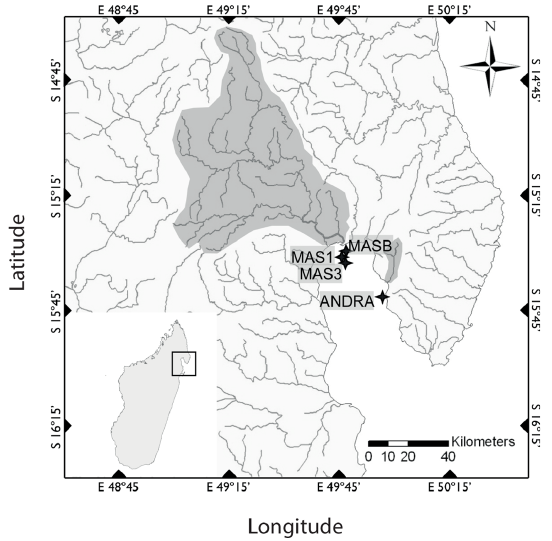
Fig. 1. Map of the region where coral cores MAS1, MAS3, MASB and ANDRA were drilled. Coral locations (stars) and their corre- sponding rivers and watersheds (grey shaded areas) are marked ac- cordingly in Antongil Bay. The largest river is the Antainambalana, influencing MAS1, MAS3 and MASB. ANDRA is also influenced by a separate river, the Ambanizana, flowing south westward into the